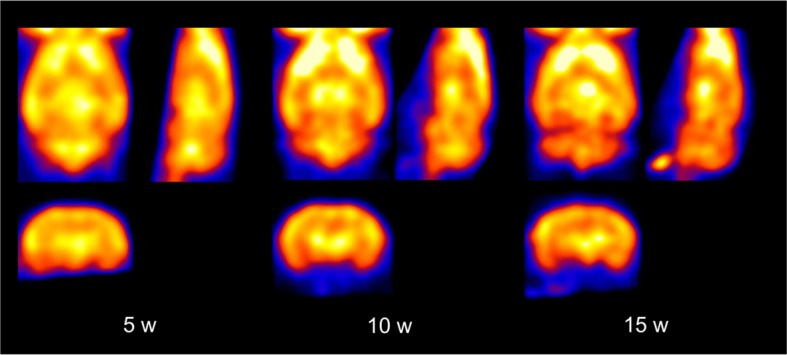
Representative FDG PET images for each age.Visual inspection can detect increase of metabolism in anterior part of the brain during maturation concordant with the results of voxelwise comparison.